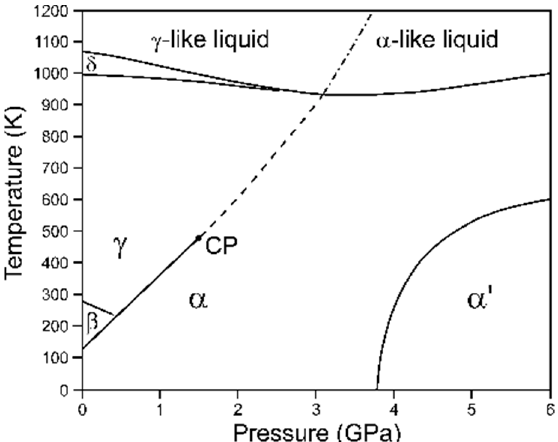
Figure 5. The phase diagram of cerium adapted from the literature data [86,87]. Solid traces denote the phase-boundary lines, and CP marks the critical point. The dashed line corresponds to the minimum observed in the isothermal-bulk-modulus plots [85]. The dash-dotted line refers to the liquid–liquid transition [86]. The phase denoted in the literature as α ” ( mC 4 in Pearson notation) and claimed to coexist with α ’ in part of its P–T field was not confirmed in the recent experimental study [87]. The stability of the α ’ and α ” structures is a matter of ongoing